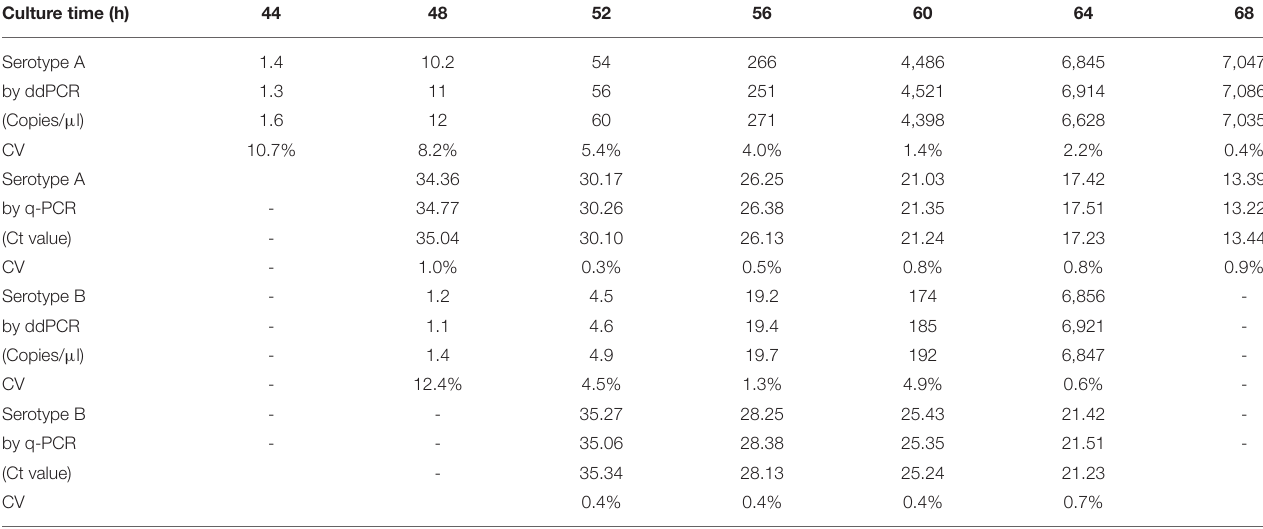
TABLE 4 | The growth of serotypes A and B strains in enrichment culture with 10 spores inoculation detected by ddPCR and q-PCR. Culture time (h)